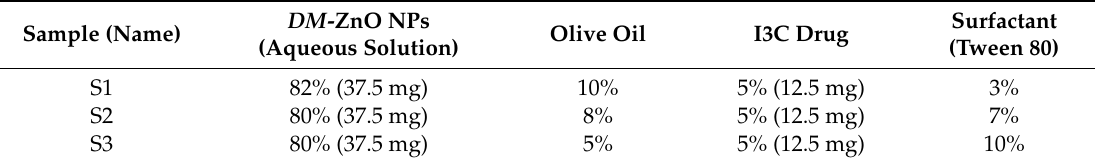
Table 1. The optimization process for nanoemulsion